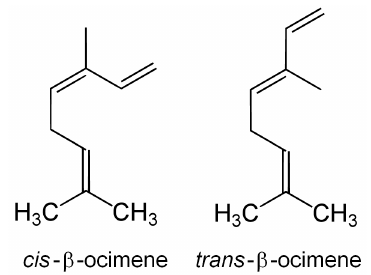
Figure 1. Chemical structure of the two β -ocimene stereoisomers, cis - and trans - β -ocimene (also referred to as ( Z )- and ( E )- β -ocimene,